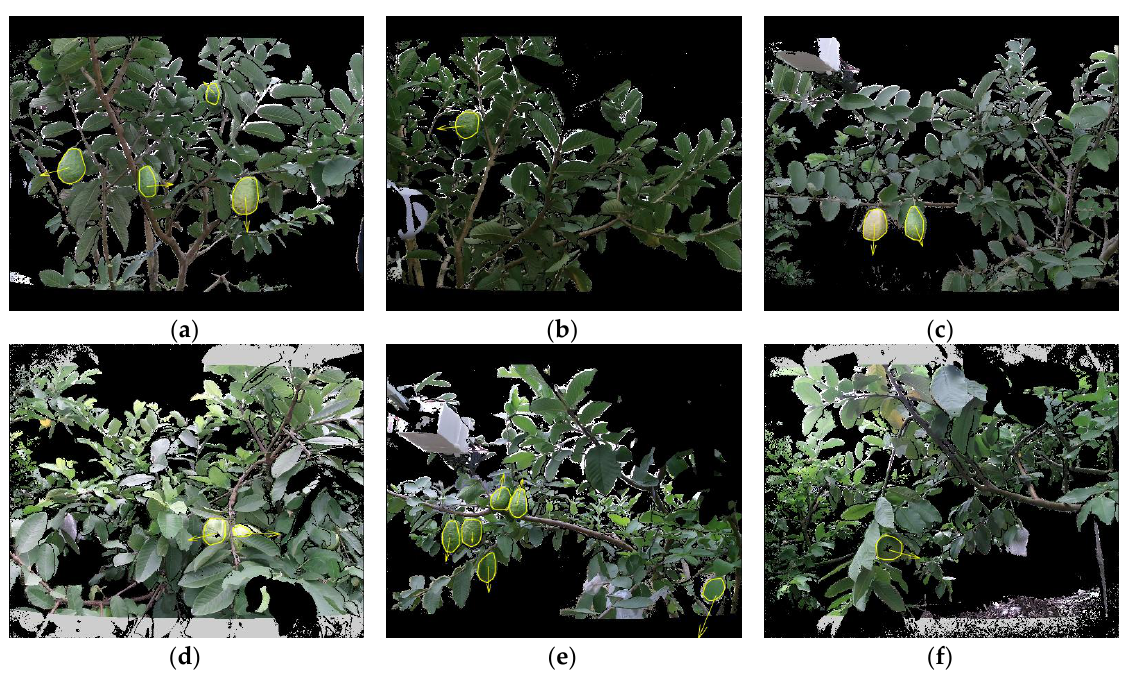
Figure 10. Examples illustrating the fruit poses estimated by the proposed algorithm. The yellow array represents the fruit pose.